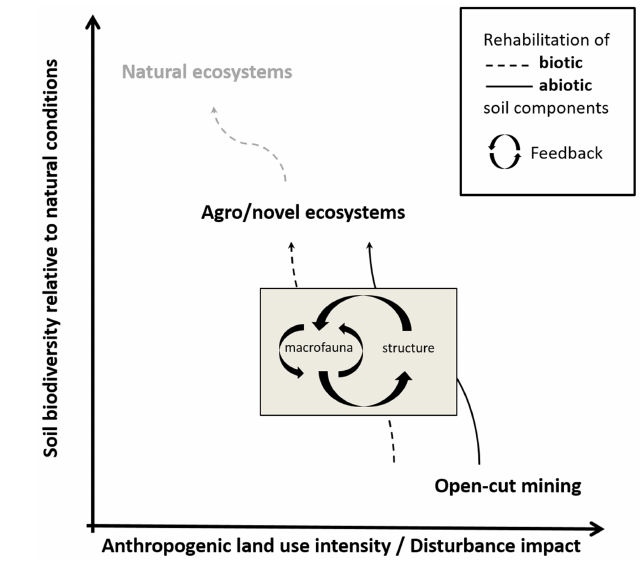
Figure 1. Relation between land use intensity/disturbance impact and soil biodiversity of natural ecosystems, conventional agricul- ture, and open-cut mining lands (modified after Bottinelli et al., 2015; Doley and Audet, 2013). While the transition from conven- tional agriculture to natural ecosystems mainly requires restoration of biotic soil components, the transition of open-cut mining land to novel (Perring et al., 2014), agricultural or native ecosystems (if possible) requires rehabilitation of both biotic and abiotic soil com- ponents. Feedbacks between different macrofauna taxa, as well as between macrofauna and soil structure, might be critical drivers of the temporal transition of open-cut mining land to novel or agricul- tural